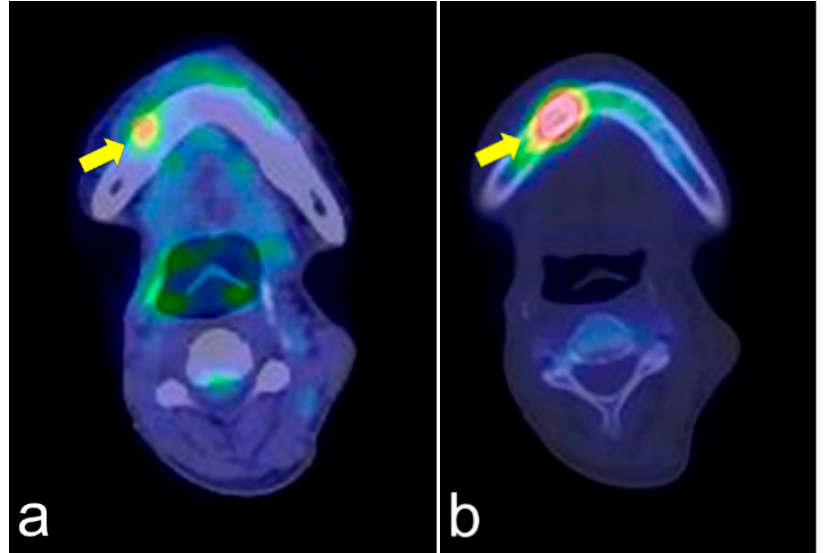
Figure 4. PET/CT ( a ) and single-photon emission computed tomography (SPECT) ( b ) images of the same lesion. PET/CT clearly shows soft tissue inflammation around the ORN area, while SPECT specifically shows bone inflammation. This comparison would help detect tumor